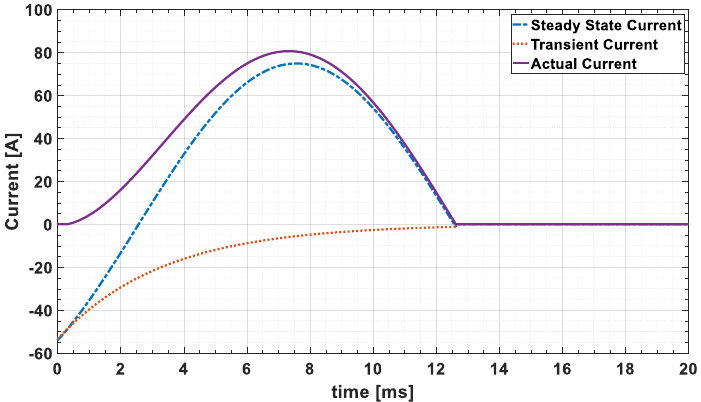
Figure 6. Simulated shape of the current.